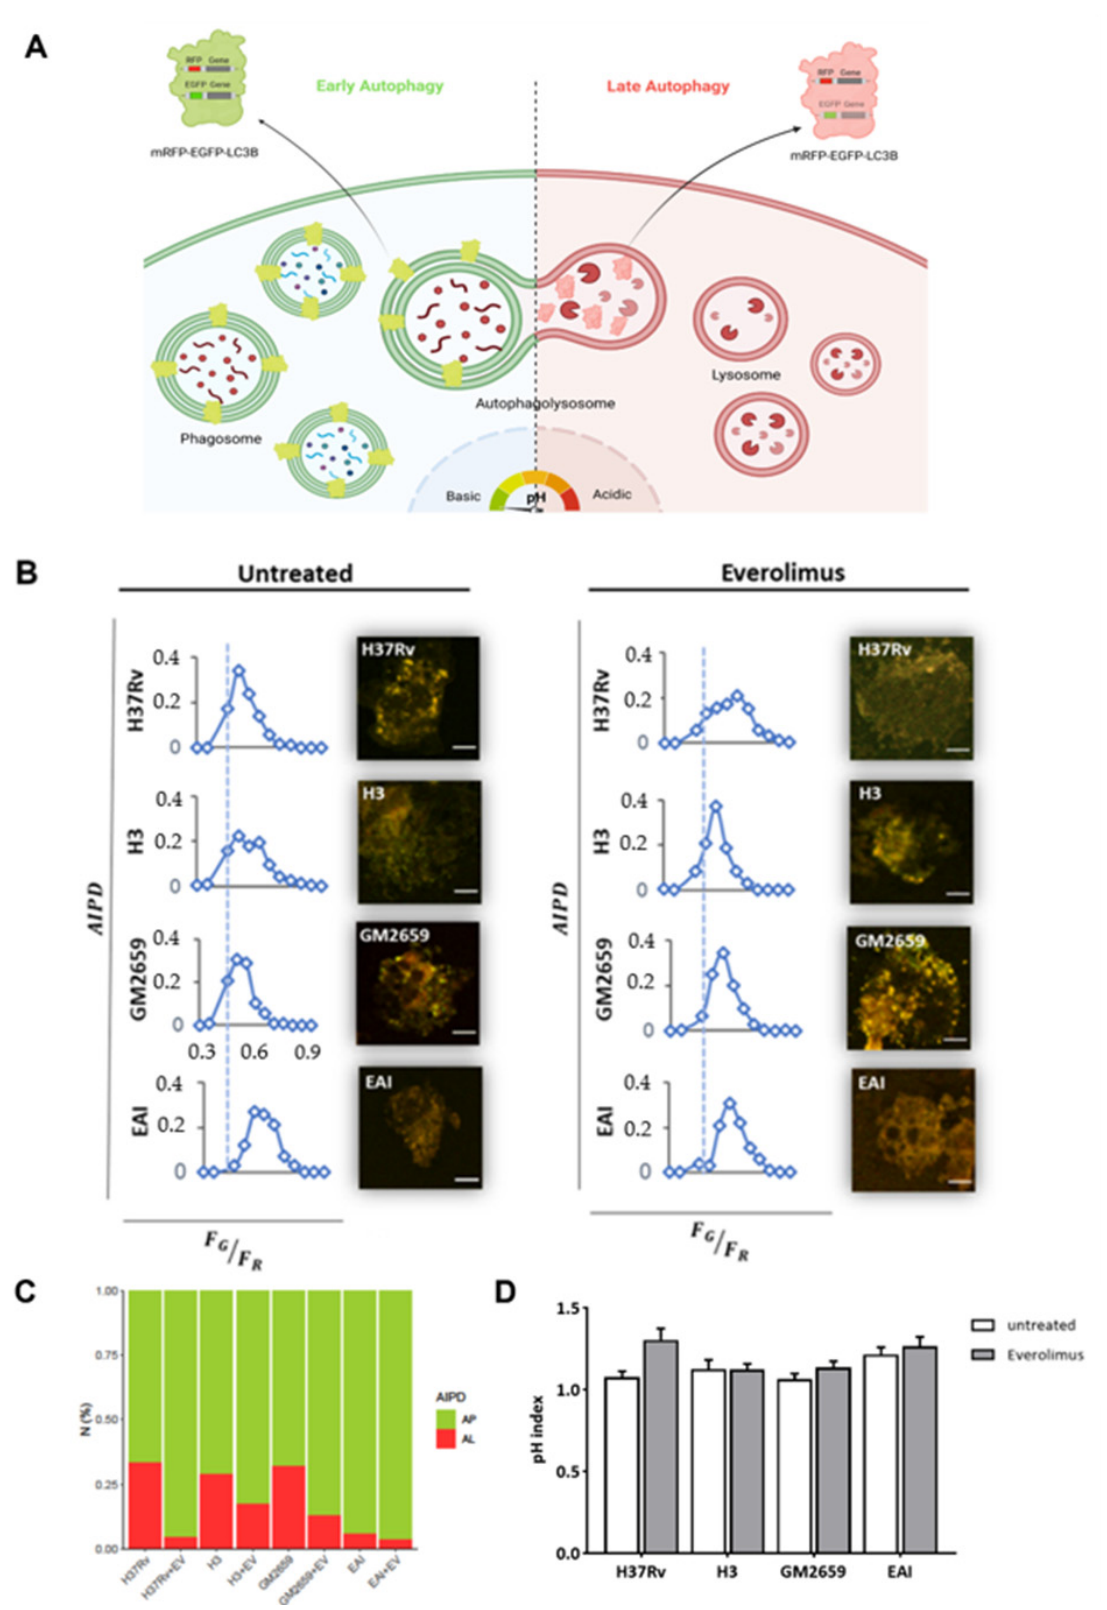
Figure 3. Schematic representation of the mRFP-EGFP-LC3B reporter system used to assess the impact of Everolimus on the autophagic process [19]. ( A ) THP1 cells constitutively express a recombinant LC3B linking mRFP and EGFP. When autophagosomes fuse with a lysosome the